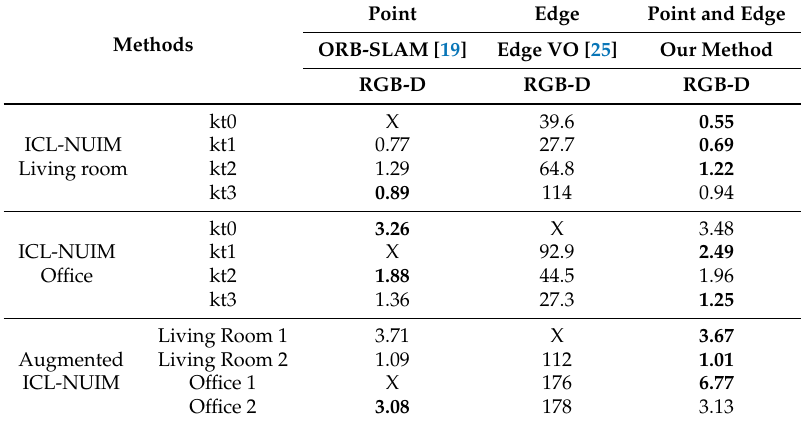
Table 3. The accuracy of camera tracking (ATE RMSE in centimeters) via points and edges on the ICL-NUIM [38] and Augmented ICL-NUIM [12] datasets. Bold shows the best results. X denotes uninitialized or the tracking